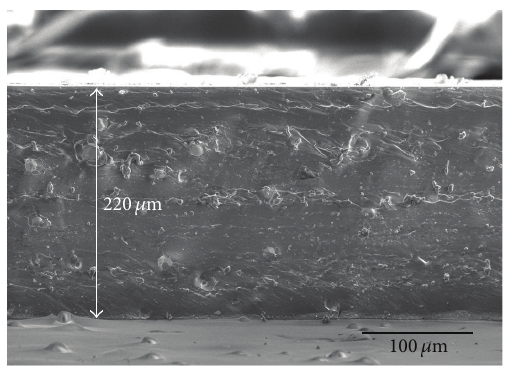
Figure 2: The angle-view SEM image of the yellow phosphor embedded flexible PDMS film.